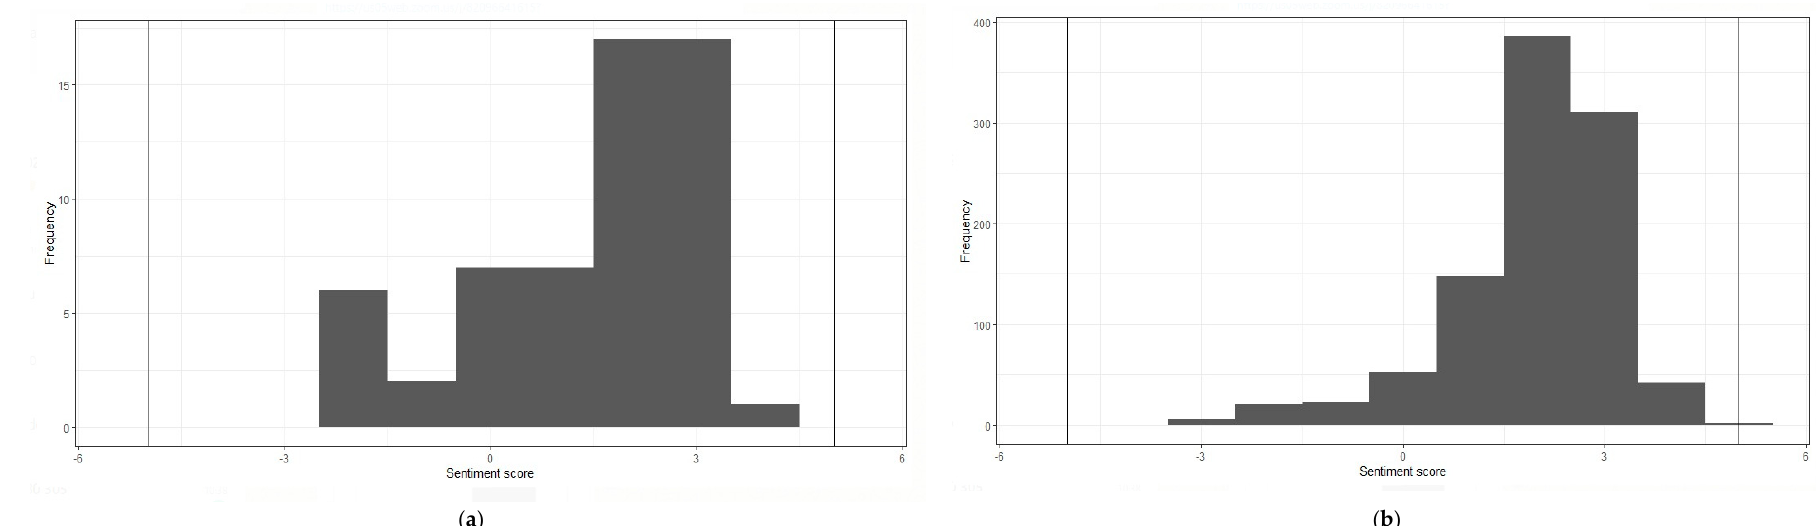
Figure A2. Histogram of sentiment score before and during pandemic: ( a ) before the pandemic, ( b ) during the pandemic.